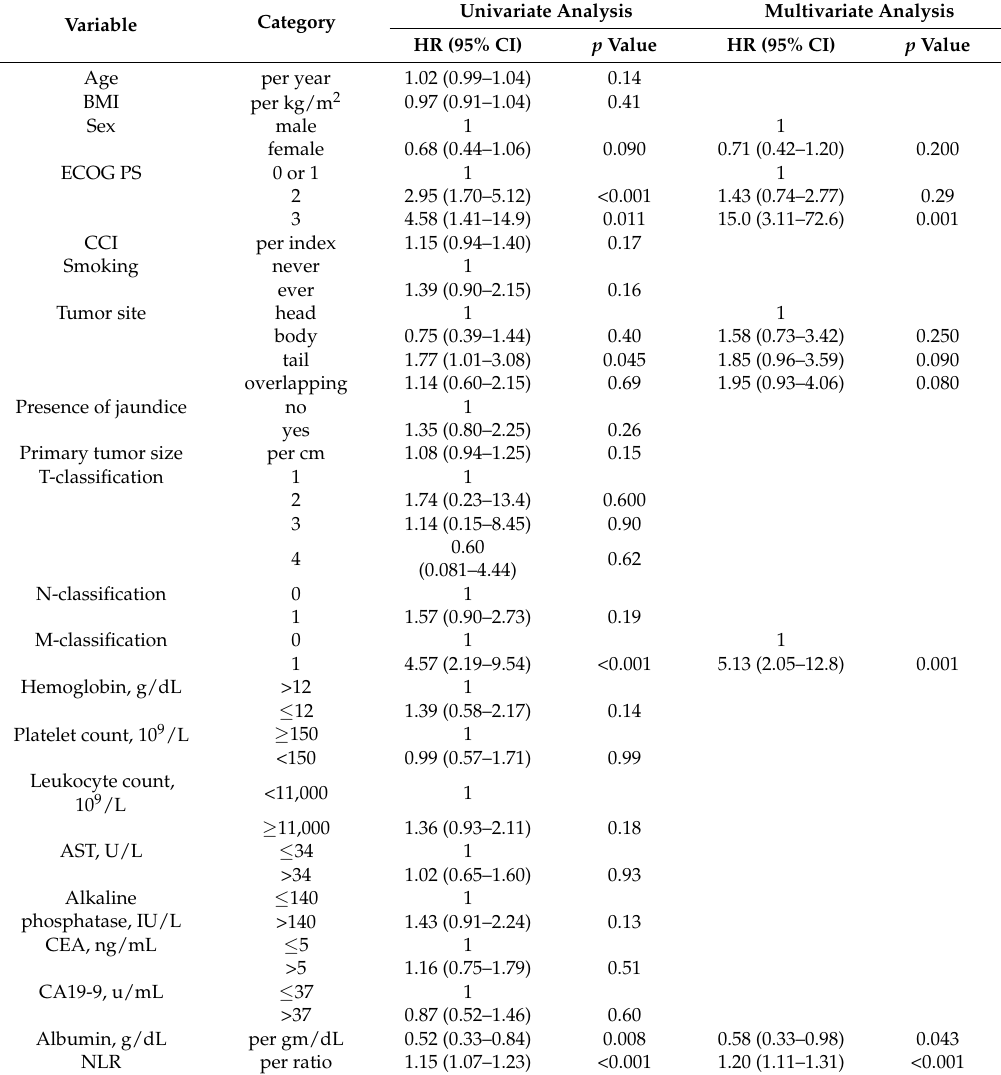
Table 2. Univariate and multivariate analyses for overall survival.